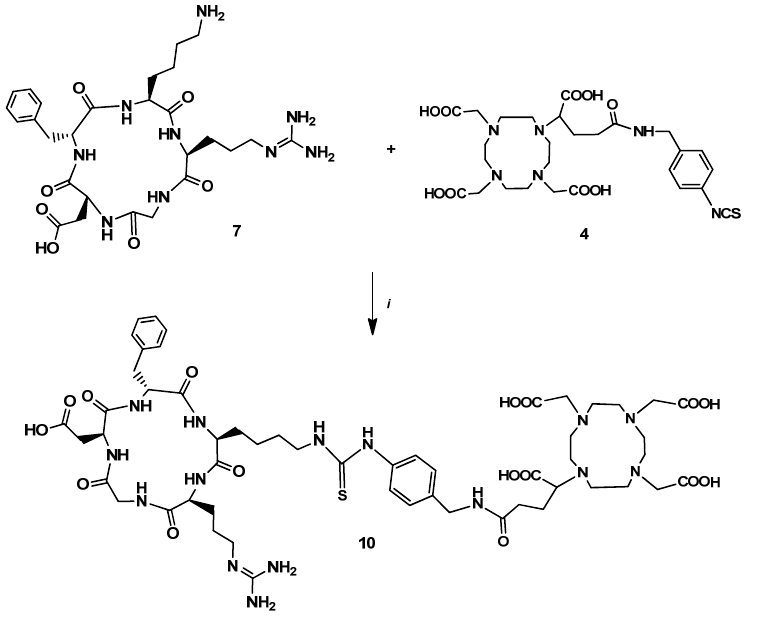
Figure 5. Reagents and conditions: (i) DMSO, Na 2 CO 3 buffer (0.1 M, pH 9.5), rt, 24 h, 10%.